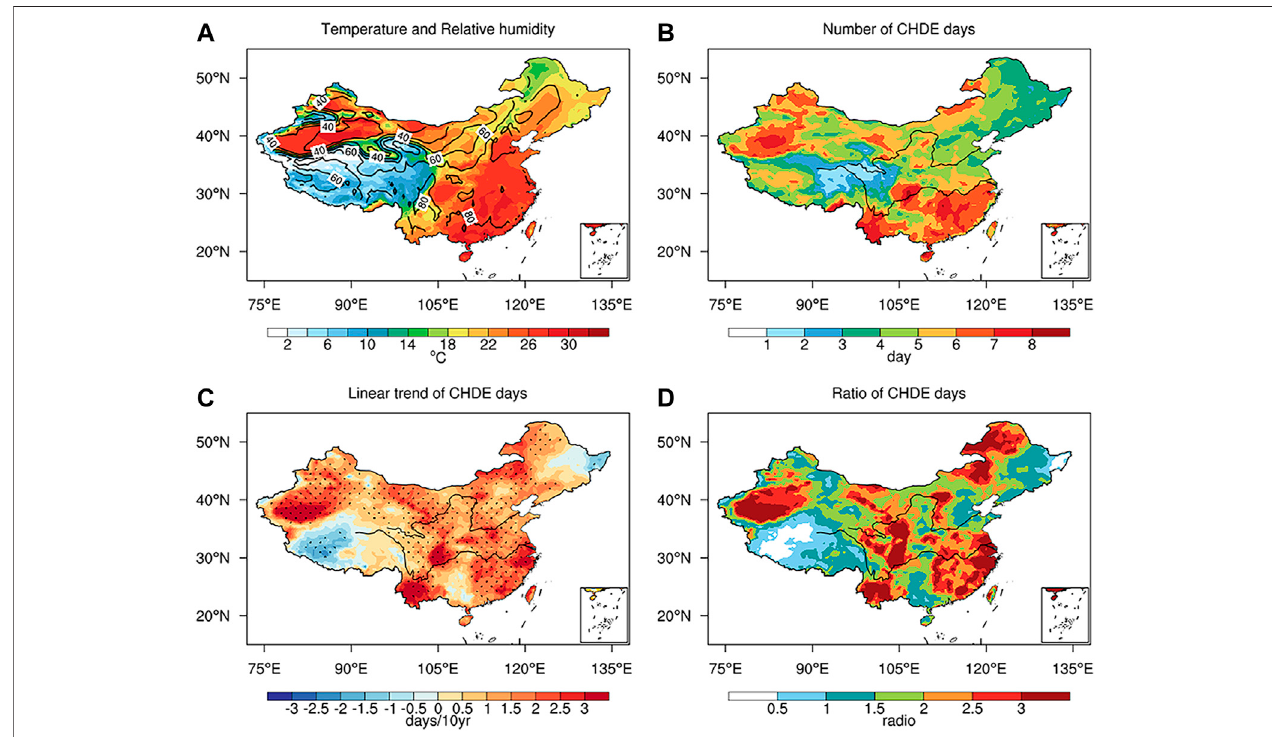
FIGURE1|(A) Climatologyofaveragedailytemperature(unit: ° C)and humidity(unit:%) insummer(JunetoAugust)inChinafrom1981to2020. (B) Number(unit: day), (C) lineartrend(unit:day/10 years),and (D) ratio(latter20 yearscomparedtoprevious20 years) ofsummerCHDEdays.Dottedareas in (C) indicatethatthelinear trend of CHDEs in these regions exceeds the 95% con fi dence